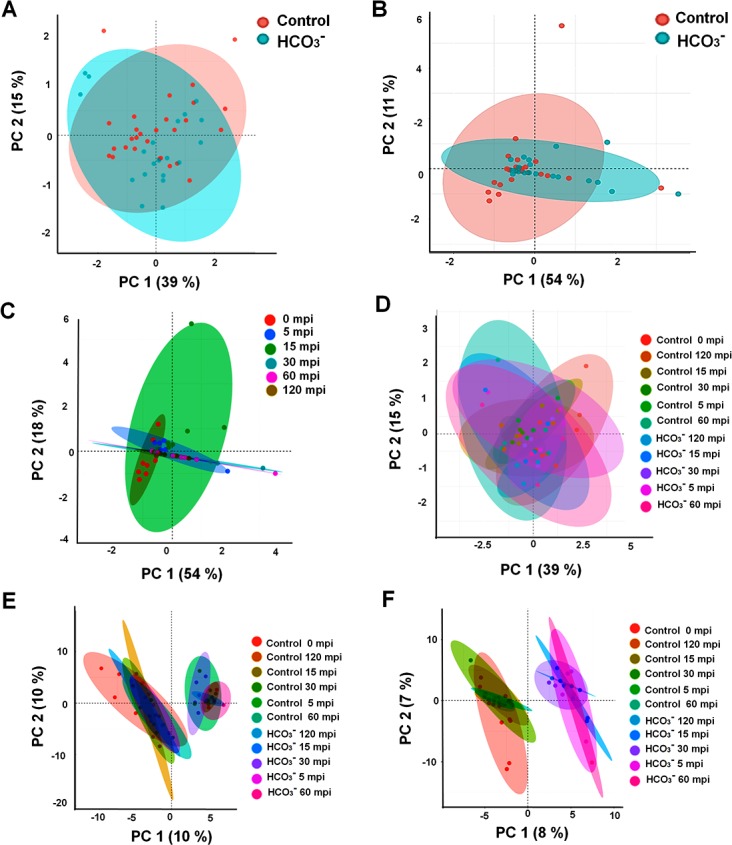
Principal component analysis (PCA) and orthogonal partial least square discriminant (OPLS-DA) analysis of metabolite changes in GCs and MCs after HCO3
- treatment.PCA was performed using four replicate data of relative metabolite abundances in the cell-types at 0, 5, 15, 30, 60, 120 mpi, and the generated PC1 and PC2 were plotted. PCA of two cell-types showing a clear separation of the two groups based on the 268 metabolites for the effect of treatments in (A) GCs, and (B) MCs. The effects of only (C) time and both (D) ‘treatment x time’ were displayed. In OPLS-DA, the metabolite changes as a result of interactions among ‘cell-type x treatment x time were displayed in (E) GCs and (F) MCs.